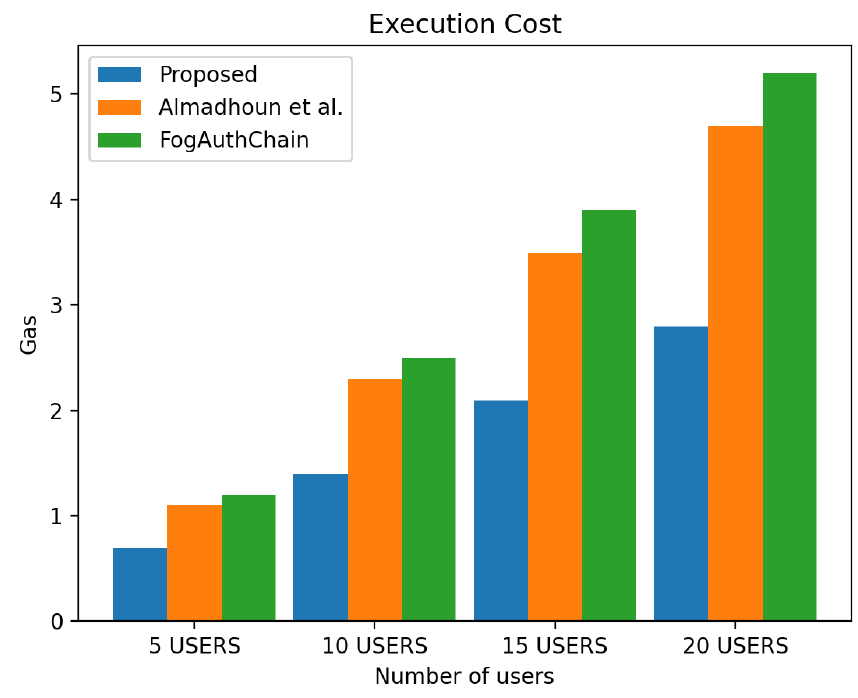
Figure 8. Comparison of experimental results of the proposed system and existing systems (Almad- houn et al. [36] and FogAuthChain [1]) on registration execution cost.